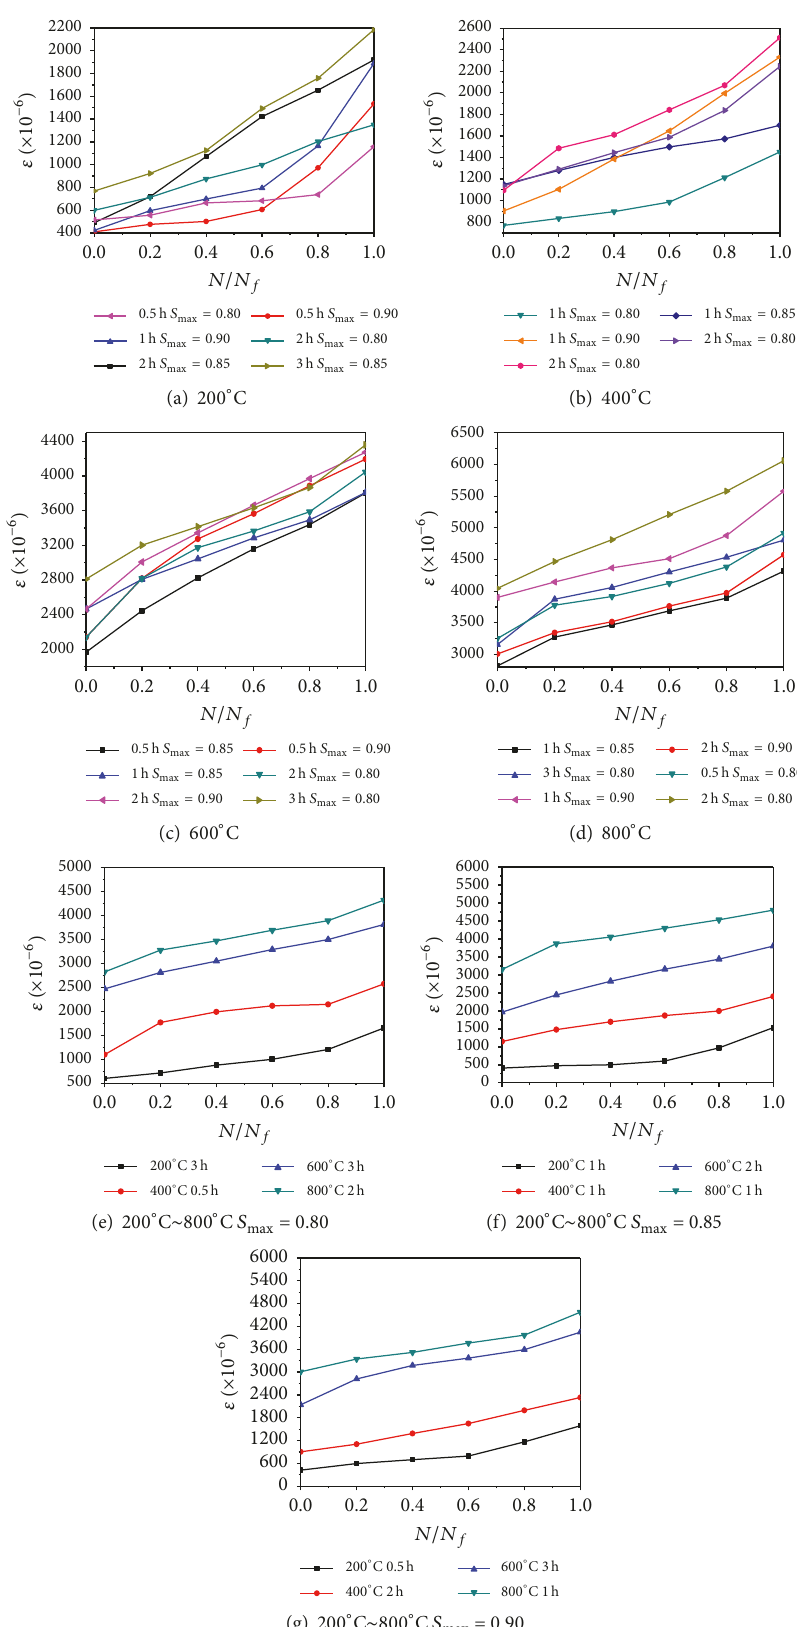
Figure 4: Relationship between fatigue strain and relative fatigue cycles: (a) 200 ∘ C; (b) 400 ∘ C; (c) 600 ∘ C; (d) 800 ∘ C; (e) 200 ∘ C ∼ 800 ∘ C, 𝑆 max = 0.80; (f) 200 ∘ C ∼ 800 ∘ C, 𝑆 max = 0.85; (g) 200 ∘ C ∼ 800 ∘ C, 𝑆 max =